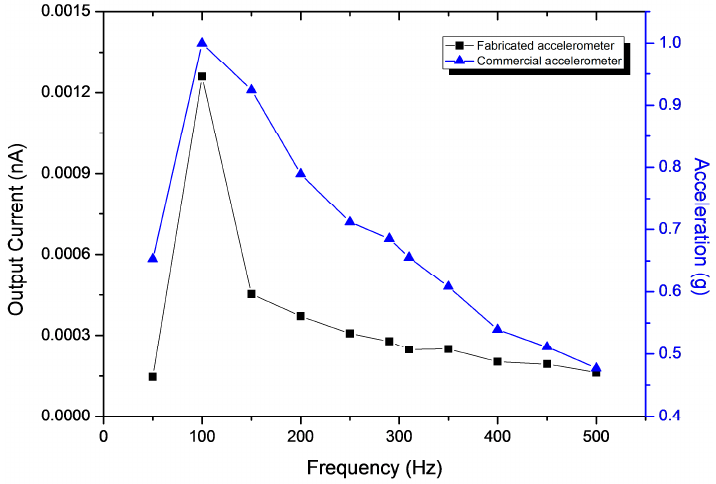
Figure 8. Performance comparison of the fabricated and commercial accelerometers.